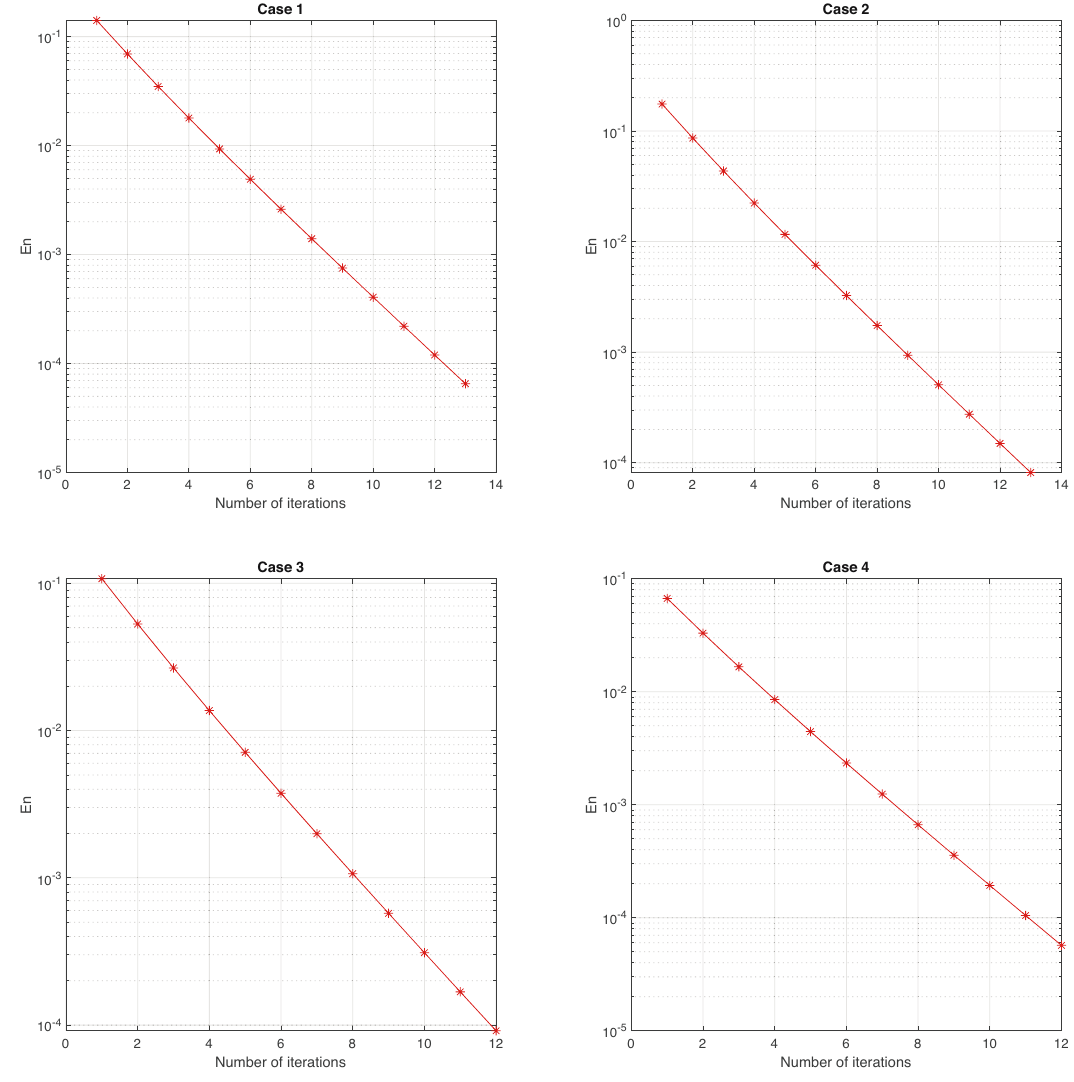
Figure 1: Example 5.1, Top left: Case 1; Top right: Case 2; Bottom left : Case 3; Bottom right: Case